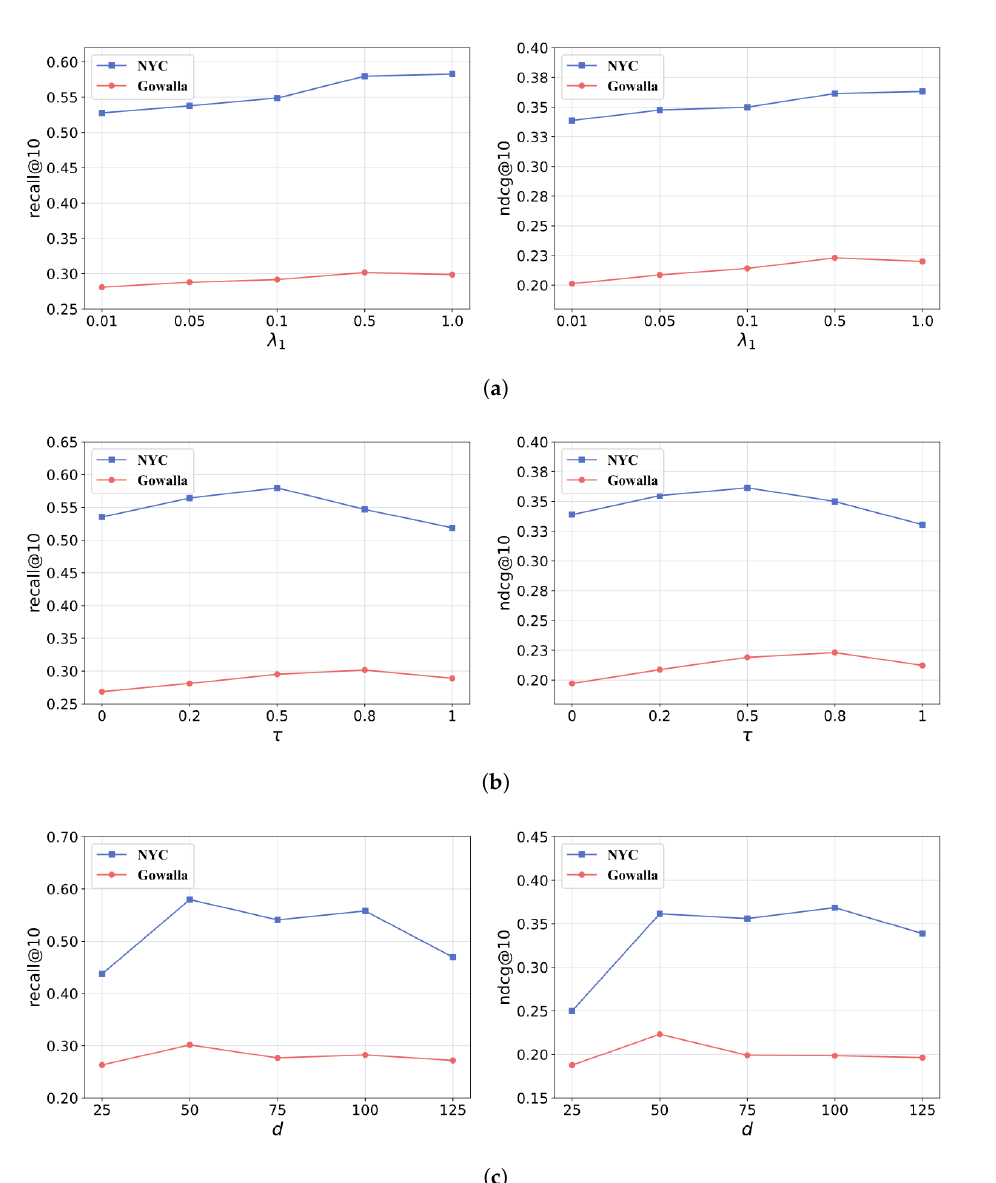
Figure 4. Impact evaluation of hyperparameters: ( a ) Impact of Parameter λ 1 ; ( b ) Impact of Parameter τ ; ( c ) Impact of Parameter d